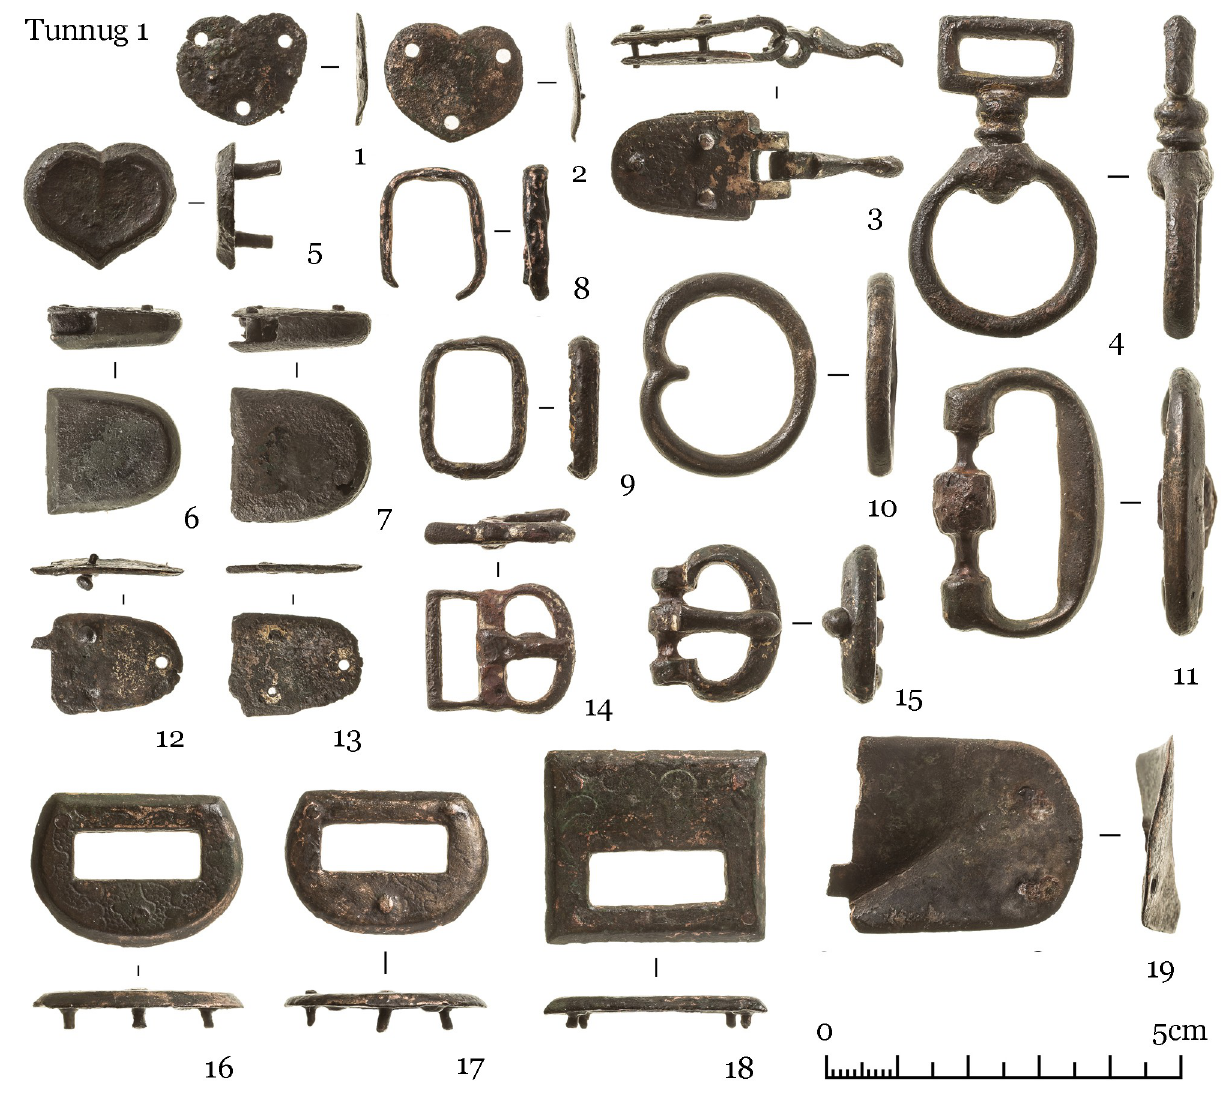
Fig 8. Bronze finds from structures 6 and